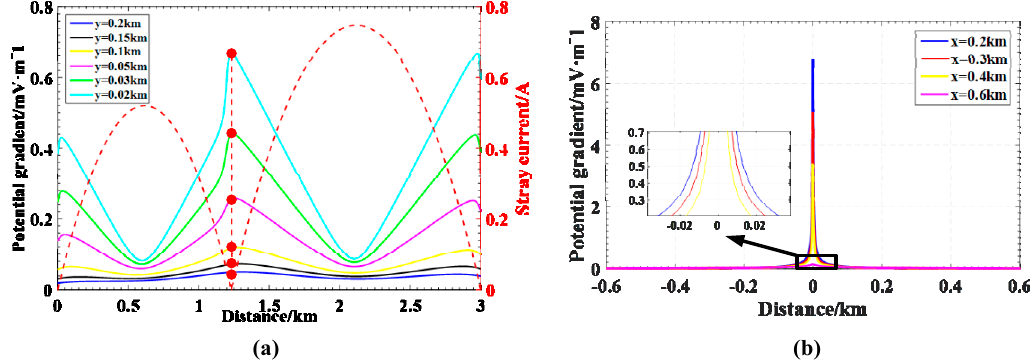
Figure 7. Surface potential gradient under the bilateral power supply: ( a ) Along the locomotive running direction; ( b ) Vertical to the locomotive running direction.